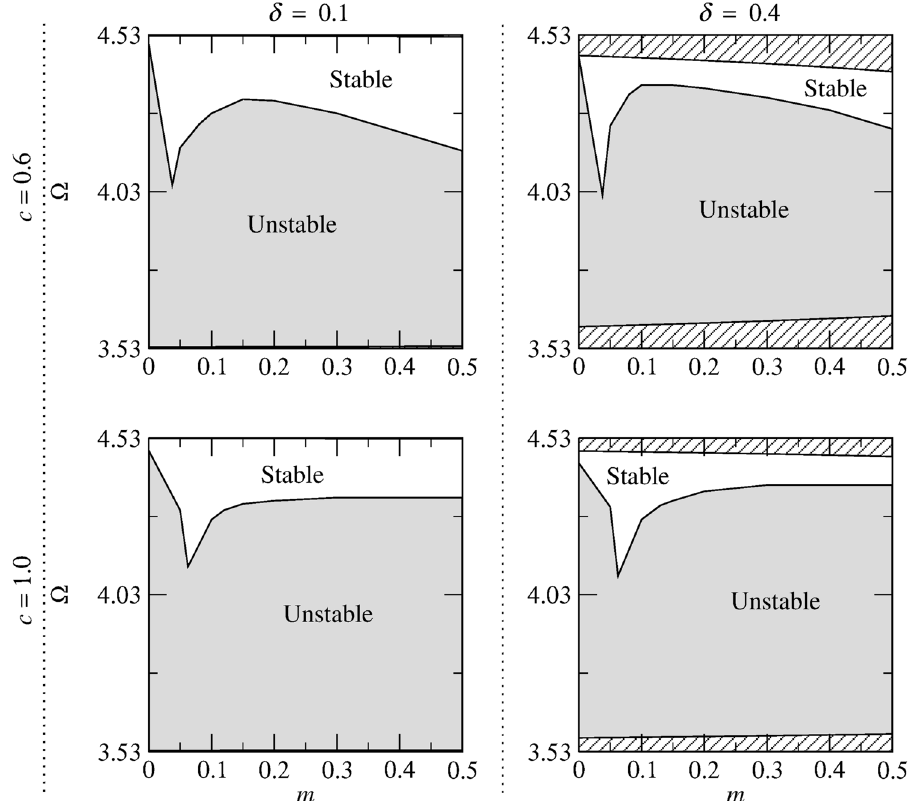
Figure 4. Stability regions corresponding to the upper gap in the ( m , Ω) plane for different values of soliton velocity (increasing δ from left to right) and relative group velocity (increasing c from top to bottom) for κ = 4. The areas which lie outside the gap and consequently do not contain soliton solutions are shown by the diagonal